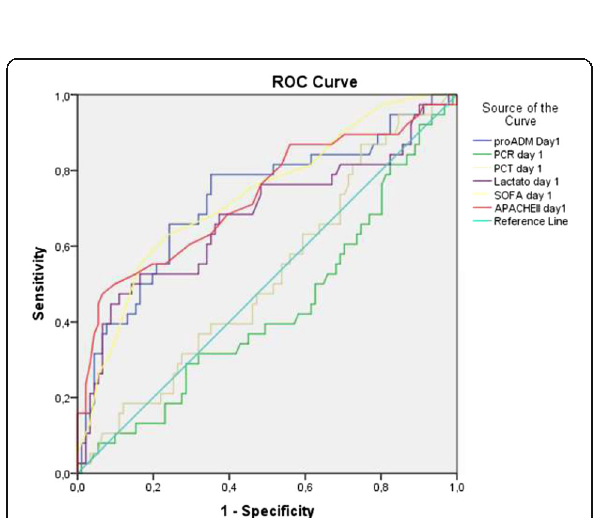
Fig. 2 (abstract 0126). AUROC for ICU mortality in septic subpopulation